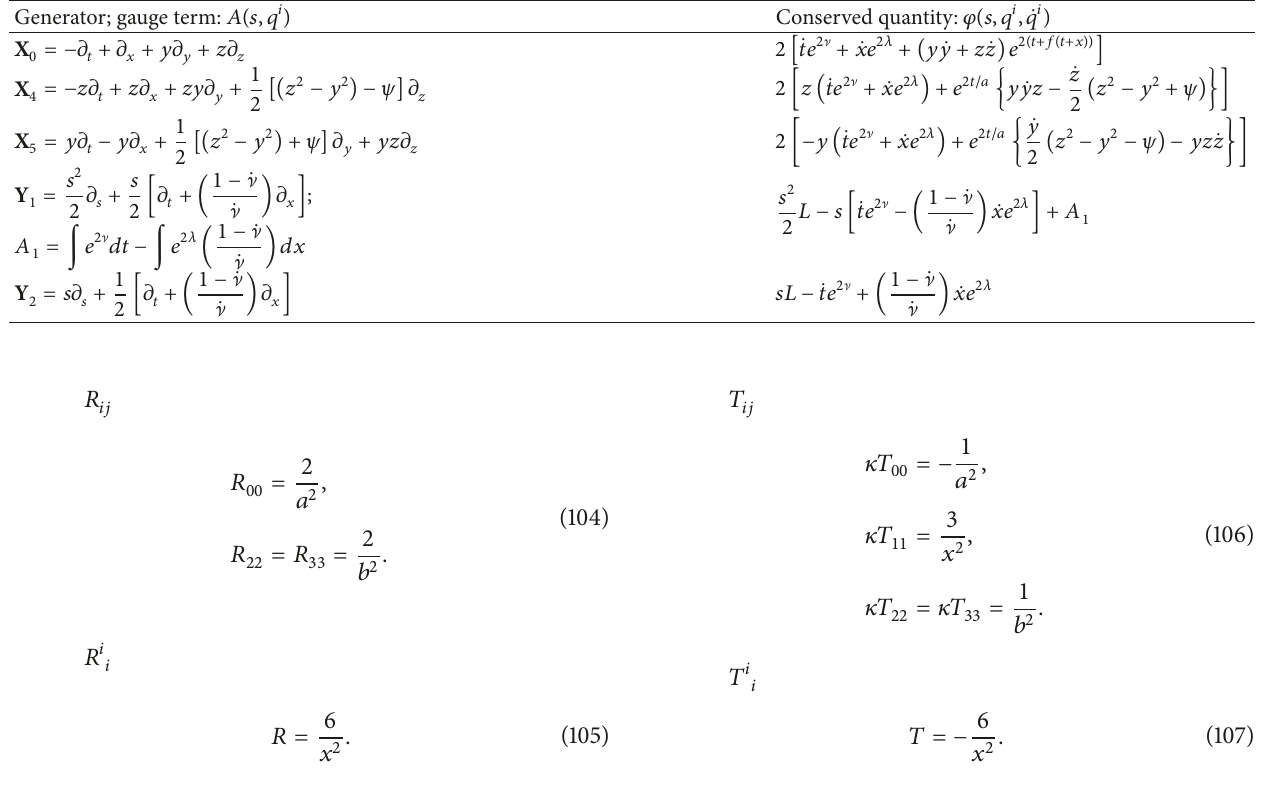
Table 20: Conserved quantities corresponding to each Noether